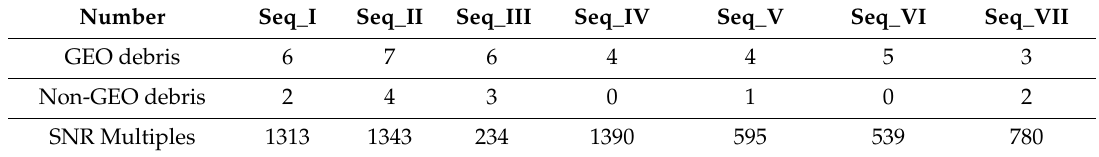
Table 2. The number of detected targets and the mean of SNR enhancement multiples.